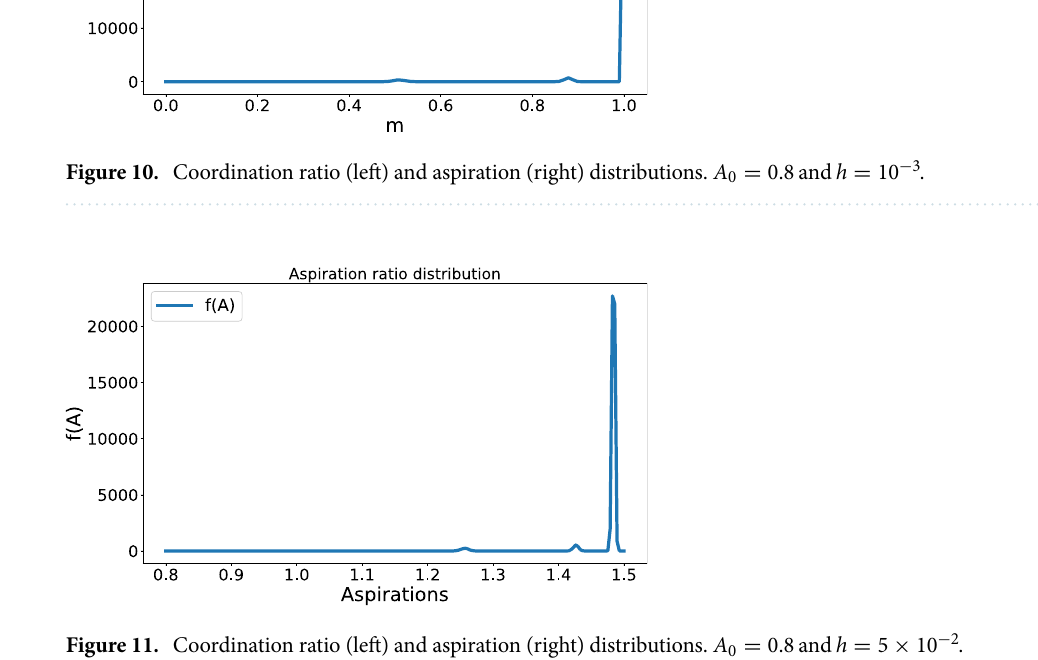
Figure 11. Coordination ratio (left) and aspiration (right) distributions. A 0 = 0.8 and h = 5 × 10 − 2